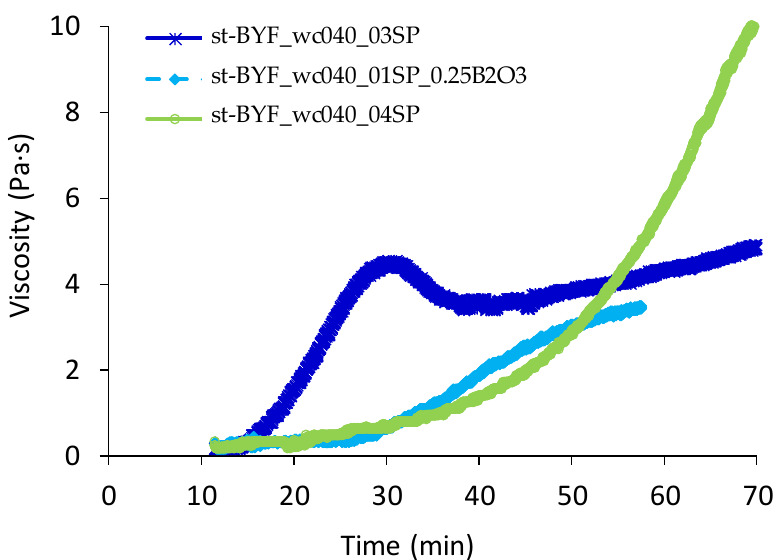
Figure 3. Evolution of the viscosity with time of st-BYF_wc040_03SP, st-BYF_wc040_01SP_0.25B 2 O 3